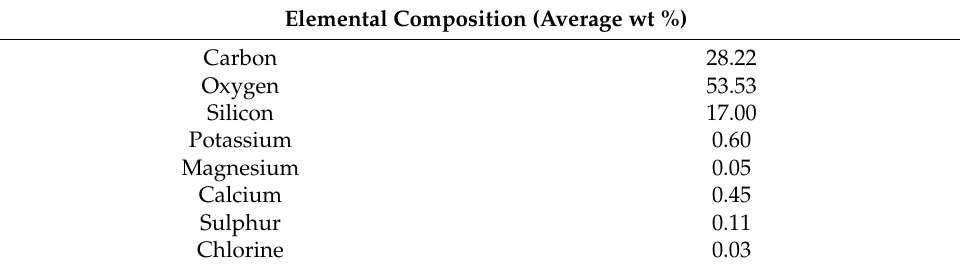
Table 1. Elemental composition of Carnaroli rice husk as determined by Energy dispersive spec- MA10 scanning electron microscope by Carl Zeiss (Oberkochen, Germany) performed on a sample after drying at 45 ◦ C for 6 h in an oven (own